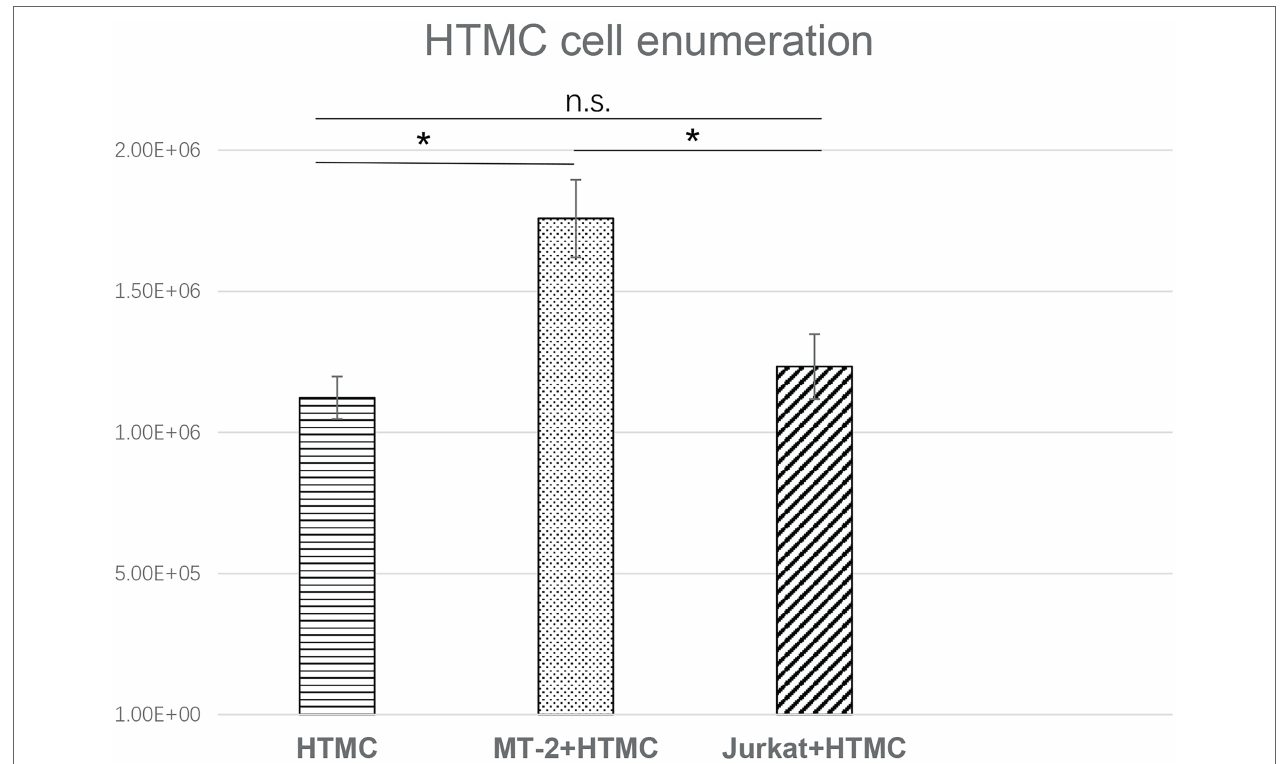
FIGURE 2 | Enumeration of HTMCs co-cultured with irradiated Jurkat cells or cultured alone per well after three transfers. The number of HTMCs at the beginning of each culture was 1.5 × 10 5 . Compared with HTMCs co-cultured with irradiated Jurkat cells or cultured alone, the number of HTMCs co-cultured with irradiated MT-2 cells was significantly increased. Data represent three independent experiments, and average values are plotted. Error bars represent standard deviation (* p < 0.05; n.s., not